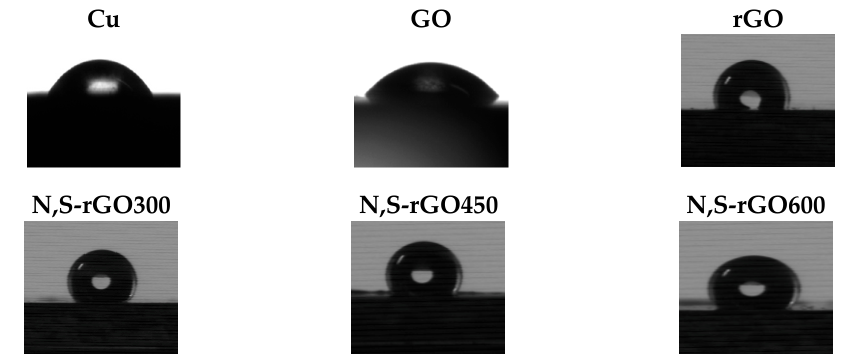
Figure 4. Atomic Force Microscopy (AFM) images for graphene coatings.